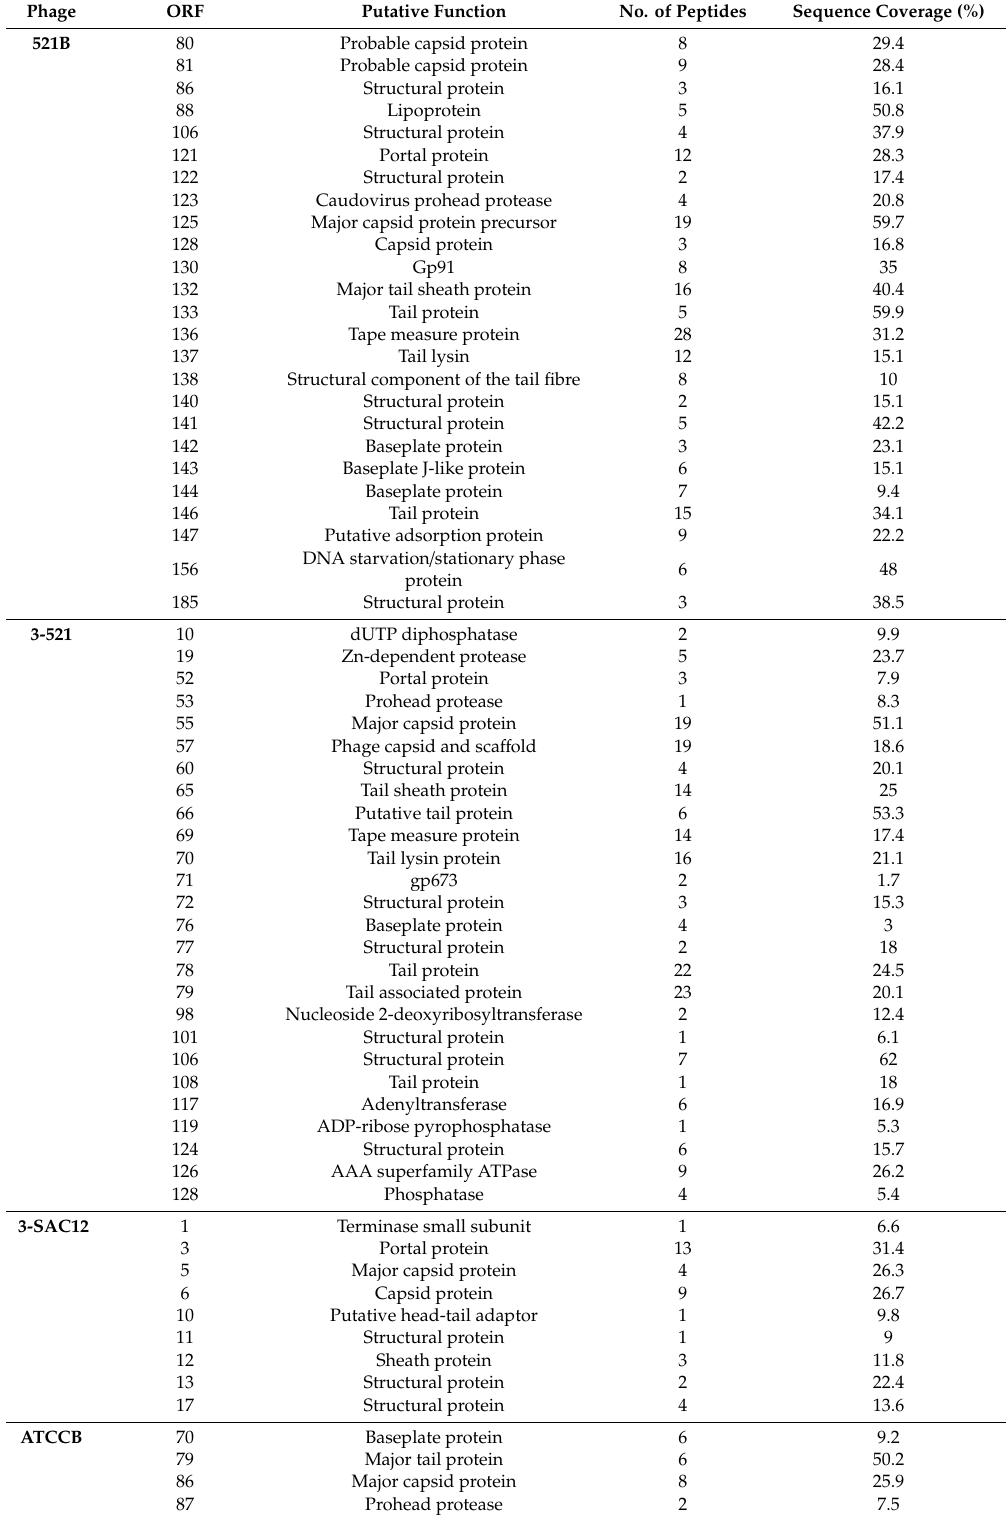
Table 4. Structural proteins extracted from purified phage particles by ESI-MS / MS. A minimum of two independent unique peptides or 5% coverage were used as threshold